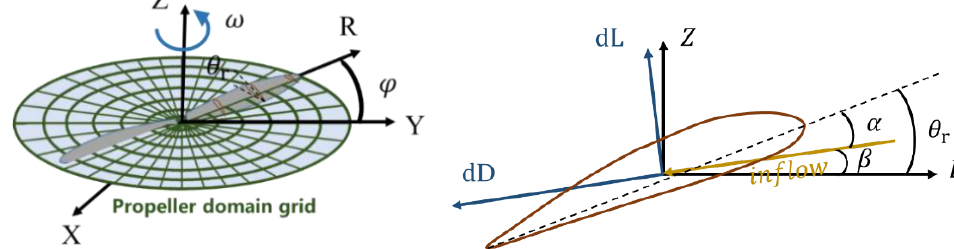
Figure 5. Schematic representation of the conversion of the blade